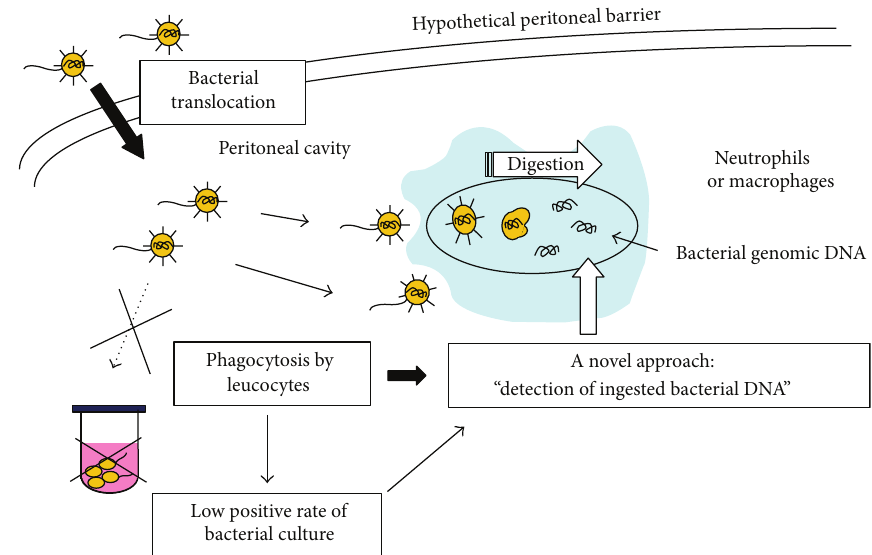
Figure 1: The concept of the ISH method for detecting bacterial DNA in SBP ascites.